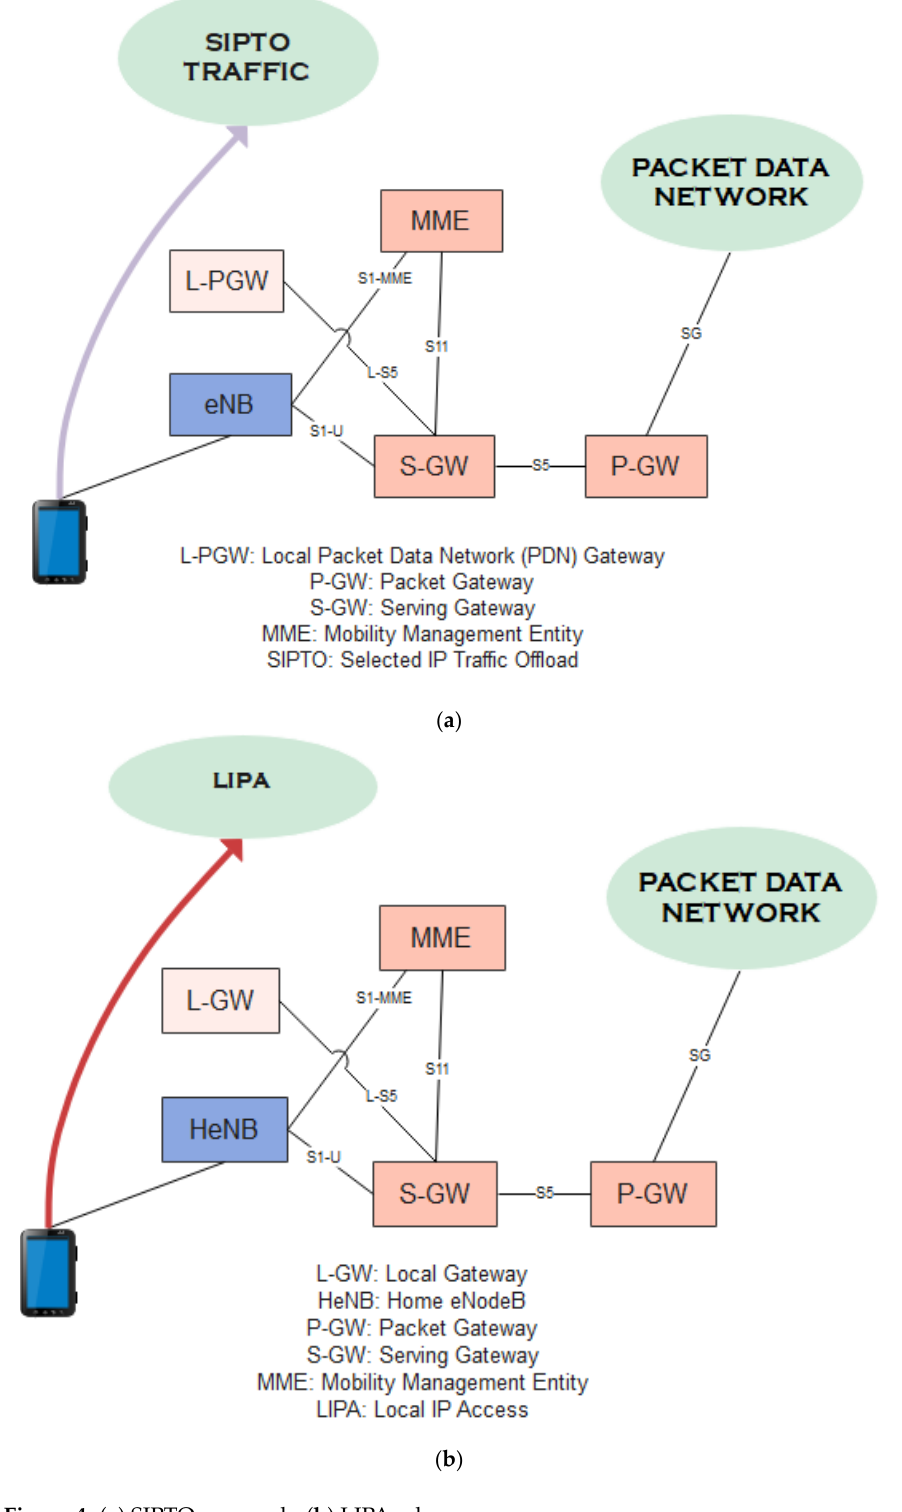
Figure 4. ( a ) SIPTO approach. ( b ) LIPA scheme.